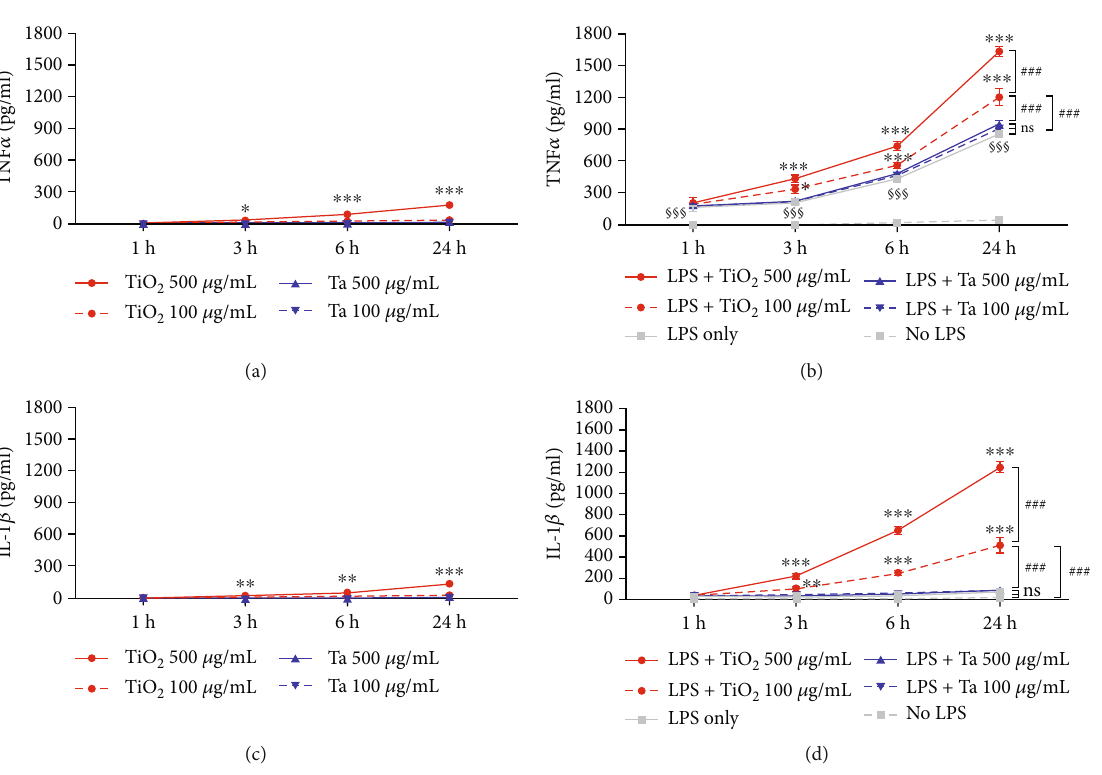
Figure 6: Proin fl ammatory potential of TiO and Ta NPs on THP-1-derived macrophages. THP-1-derived macrophages were primed with 2 or Ta NPs using the indicated doses for up to 24h. Release of 200ng/mL LPS for 3 h, washed to remove the LPS, and then incubated with TiO 2 (a, b) TNF α and (c, d) IL-1 β were measured by ELISA. THP-1-derived macrophages without LPS stimulation were used as controls. ∗ indicates signi fi cant di ff erences of di ff erent time points of the TiO NP group compared to the TiO NP 1 h group ( ∗ p < 0 : 05 , ∗∗ p < 0 : 01 , 2 2 and ∗∗∗ p < 0 : 001 ). # indicates signi fi cant di ff erences compared to the TiO NP (100 μ g/mL) group at 24 h ( ### p < 0 : 001 ). § indicates 2 signi fi cant LPS-mediated TNF α release compared to the untreated group ( §§§ p < 0 : 001